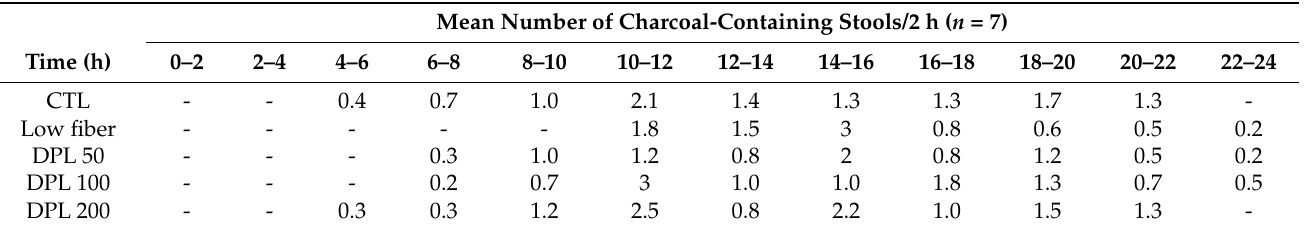
Table 1. The preventive effects of D. morbiferus H. L é v. leaf extract (DPL) on gastrointestinal (GI) motility in rats. Mean Number of Charcoal-Containing Stools/2 h ( n = 7)